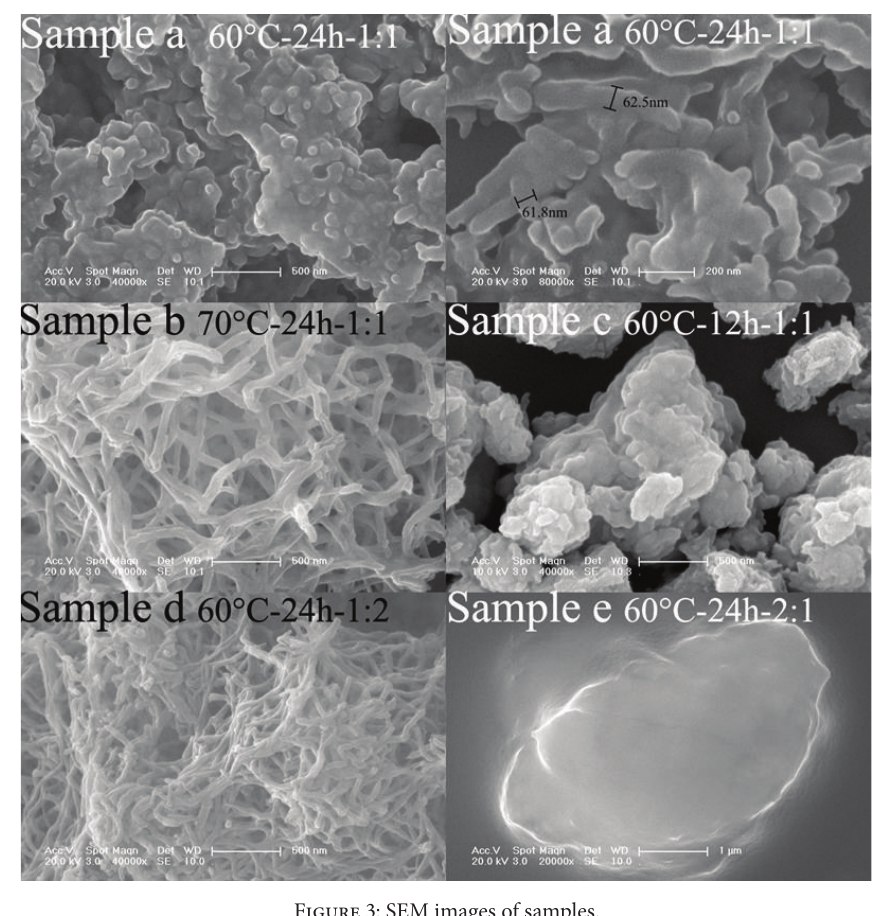
Figure 3: SEM images of samples.